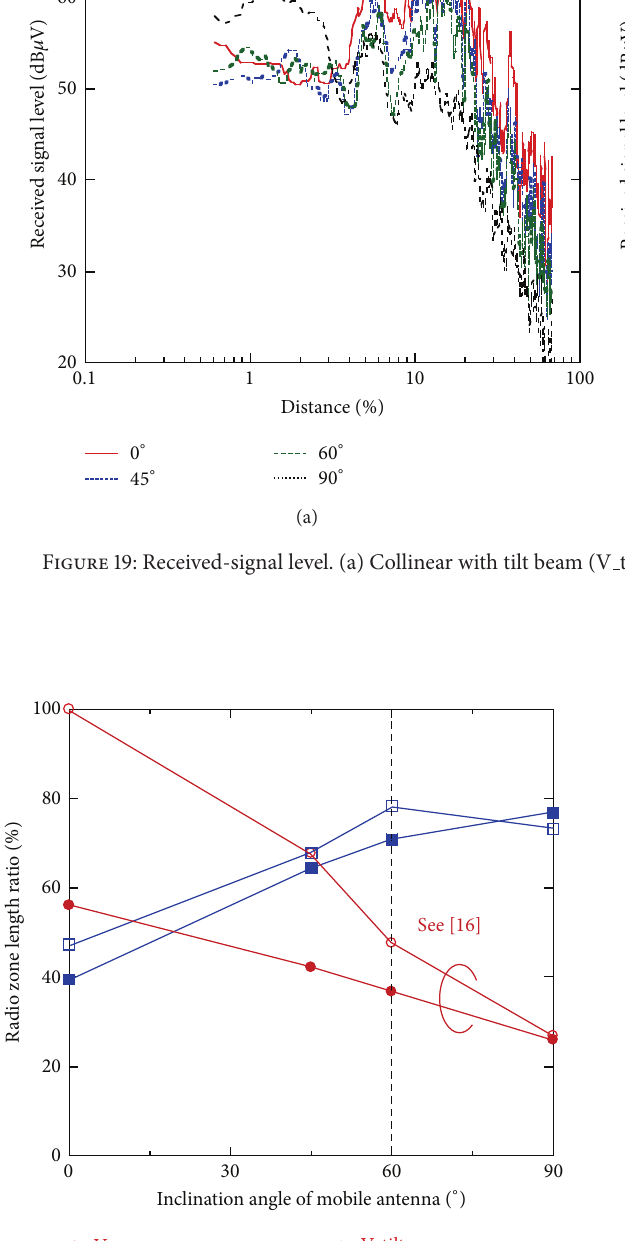
polarized omnidirectional antenna. Horizontally polarized omnidirectional mobile antennas should be used for hori- zontally polarized omnidirectional diversity BS antennas. The superiority in polarization of radio waves in land mobile communication systems remains as an important research issue to be addressed in future